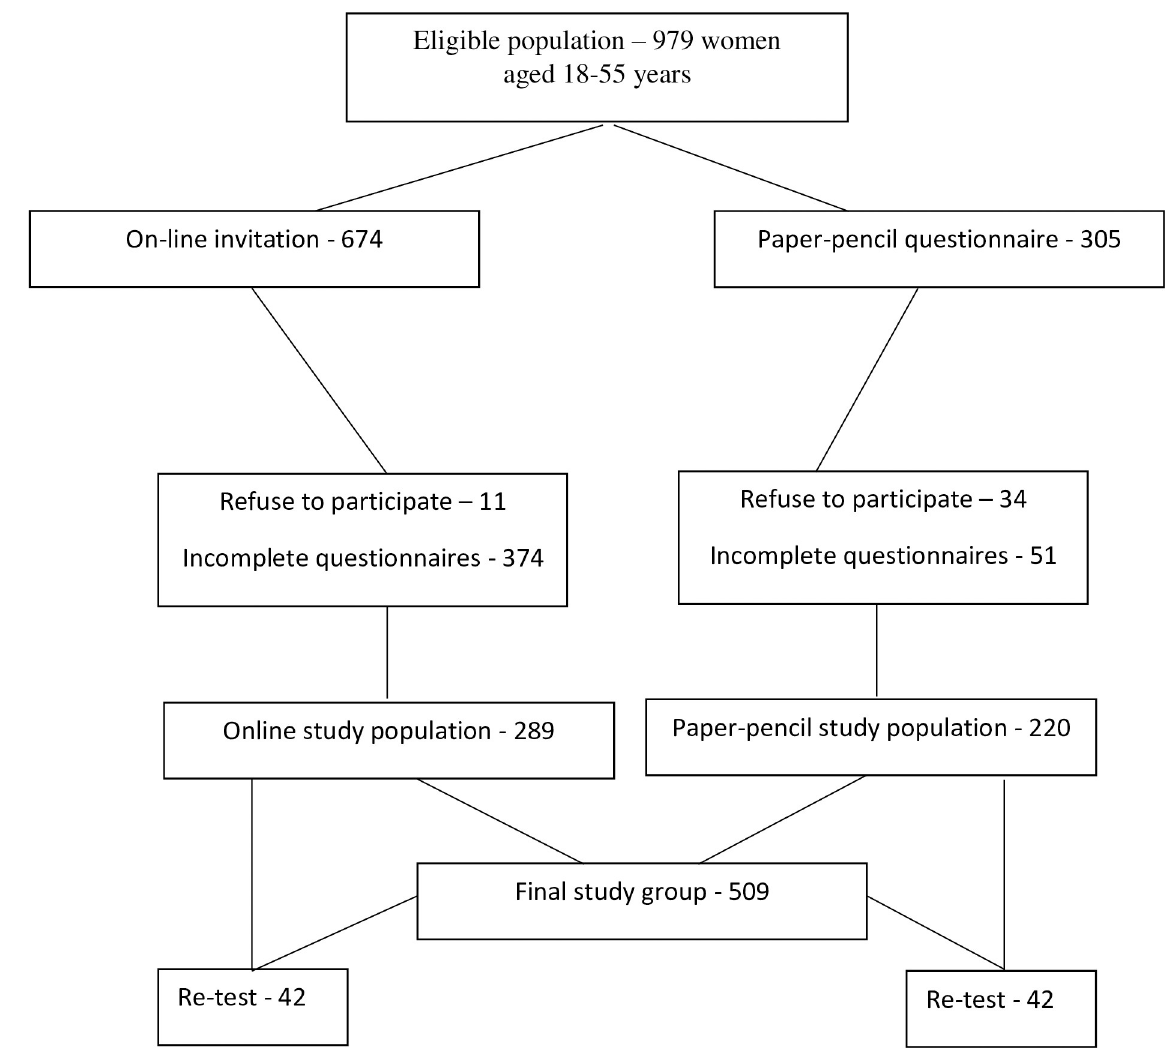
Fig 1. Study chart: Enrollment